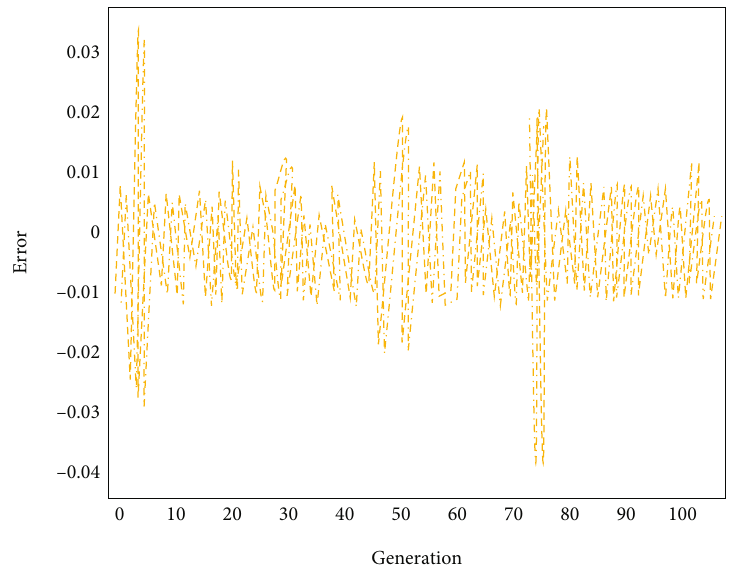
Figure 8: Multilevel fuzzy comprehensive evaluation test